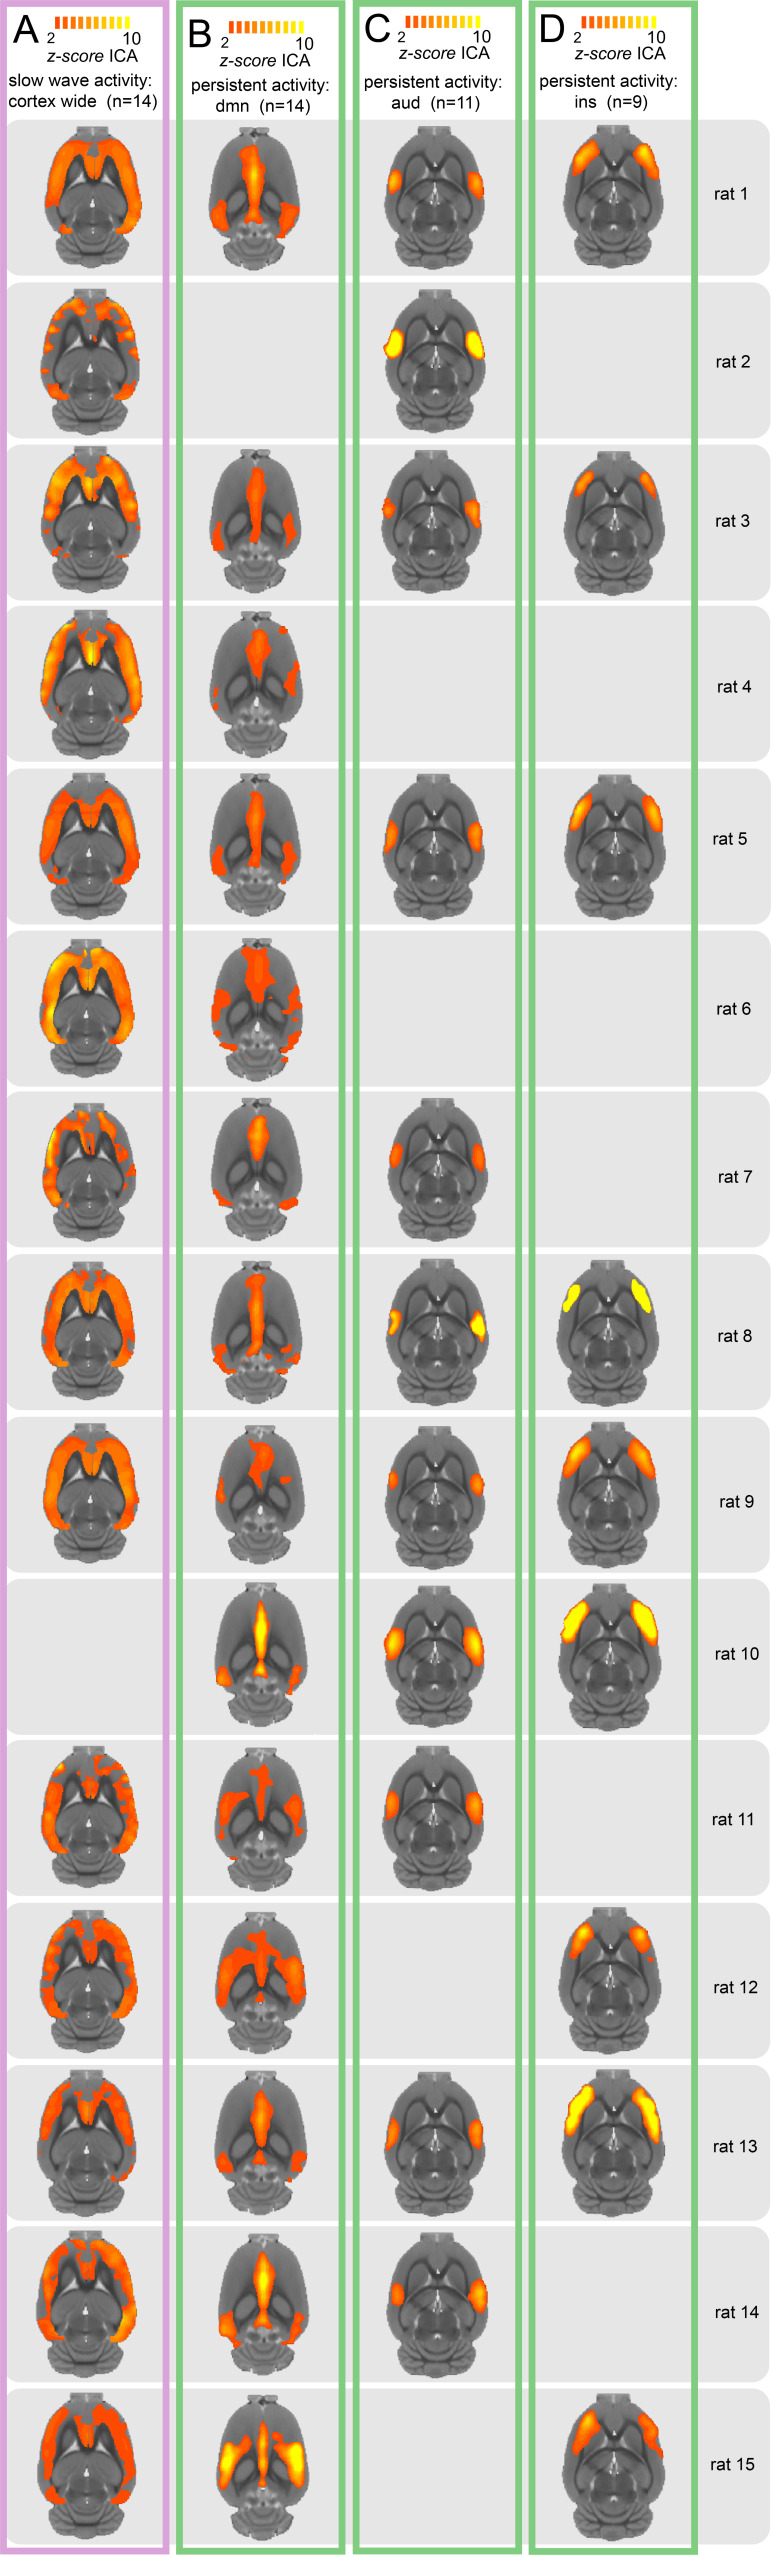
Individual z-scores obtained from the ICA for each animal shown in transversal view of an atlas template.Components of slow wave activity are shown in magenta and those found during persistent activity are shown in green. (A) Cortex wide component. (B) Default mode network. (C) Auditory network. (D) Insular activation. Last column on the right indicates the animal.